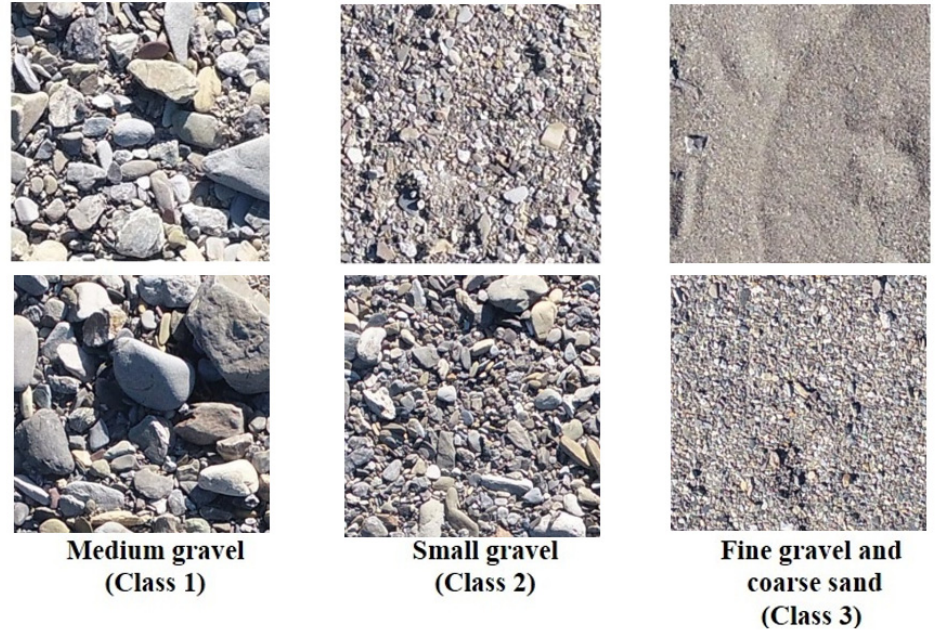
Figure 5. Aerial pictures in the quadrats from UAV.